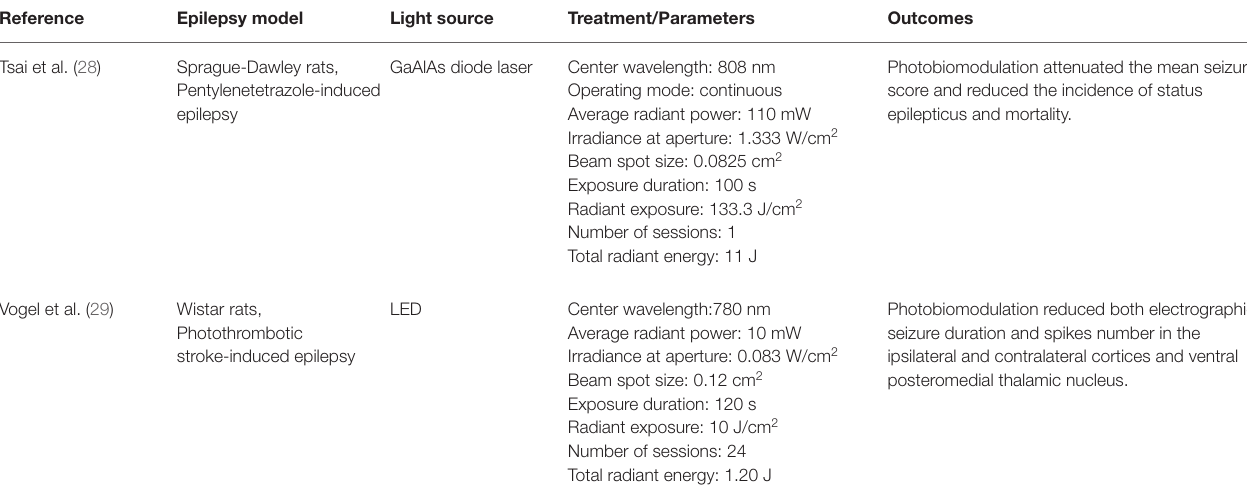
TABLE 1 | Recent evidence of PBM benefits in epilepsy models. Reference